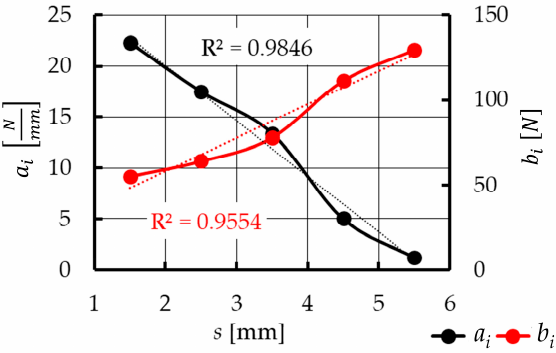
Figure 17. Exemplary correlation between the coefficients a i and b i , and the displacement s for the belt with diameter 12 mm, plasticized with velocity v pl = 10 mm/min and with the temperature of the hot plate T p = 285 °C.